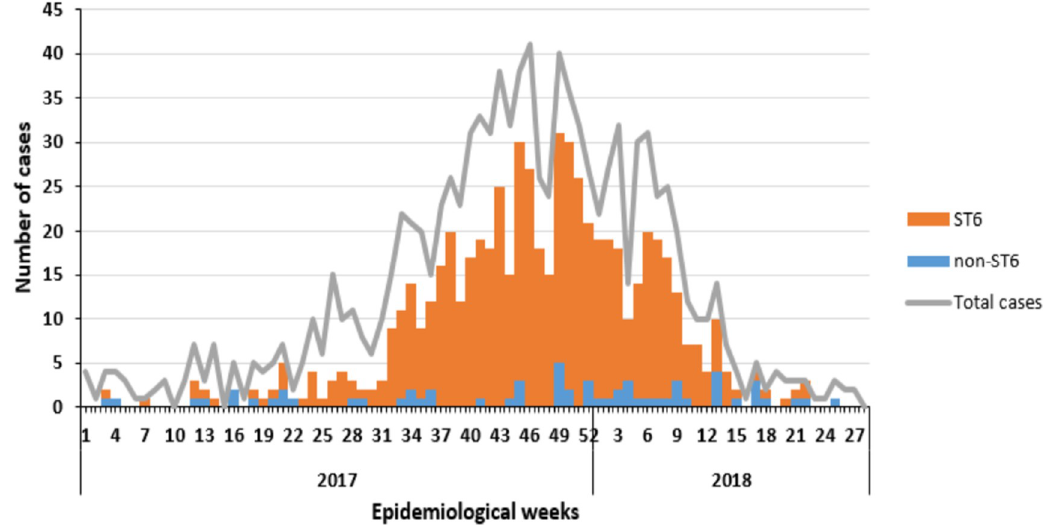
Figure 3. Epidemic curve of laboratory-confirmed cases of Listeriosis according to date of collection of clinical specimen ( N = 1060) and type of sequence (ST) ( n = 636), South Africa, 1 January 2017 to 17 July 2018 [23].